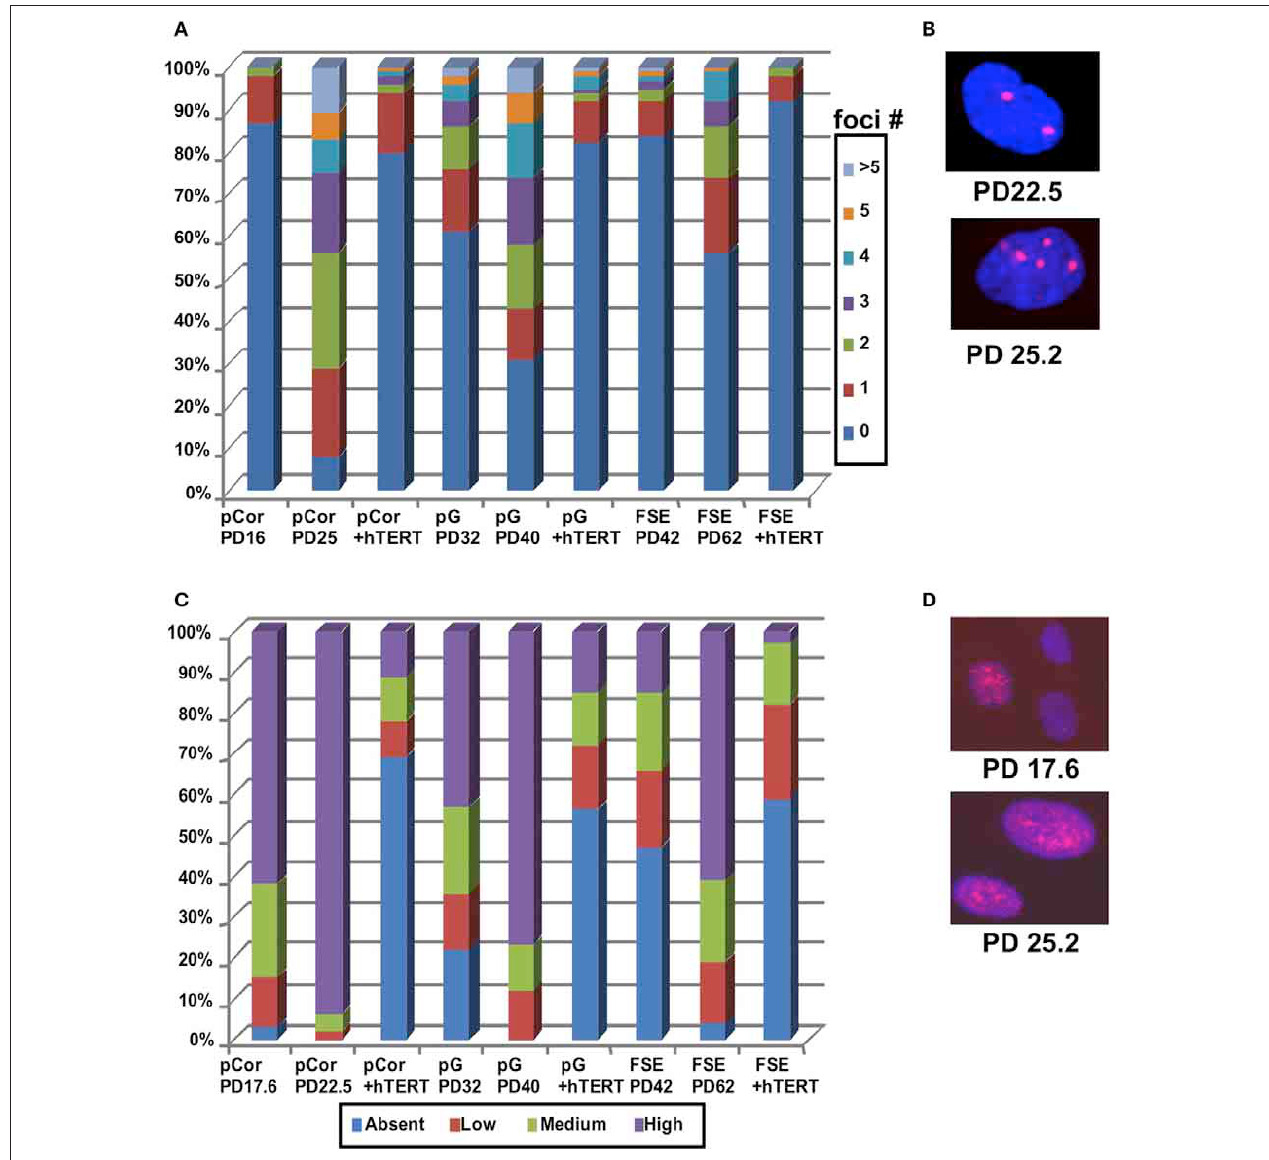
FIGURE 4 | ICF fibroblasts display high levels of γ -H2AX foci and p21 staining at abnormally low population doublings. (A) pCor, pG and FSE fibroblasts with and without expression of hTERT were stained with an antibody to γ -H2AX. Cells were scored for the number of nuclear foci.